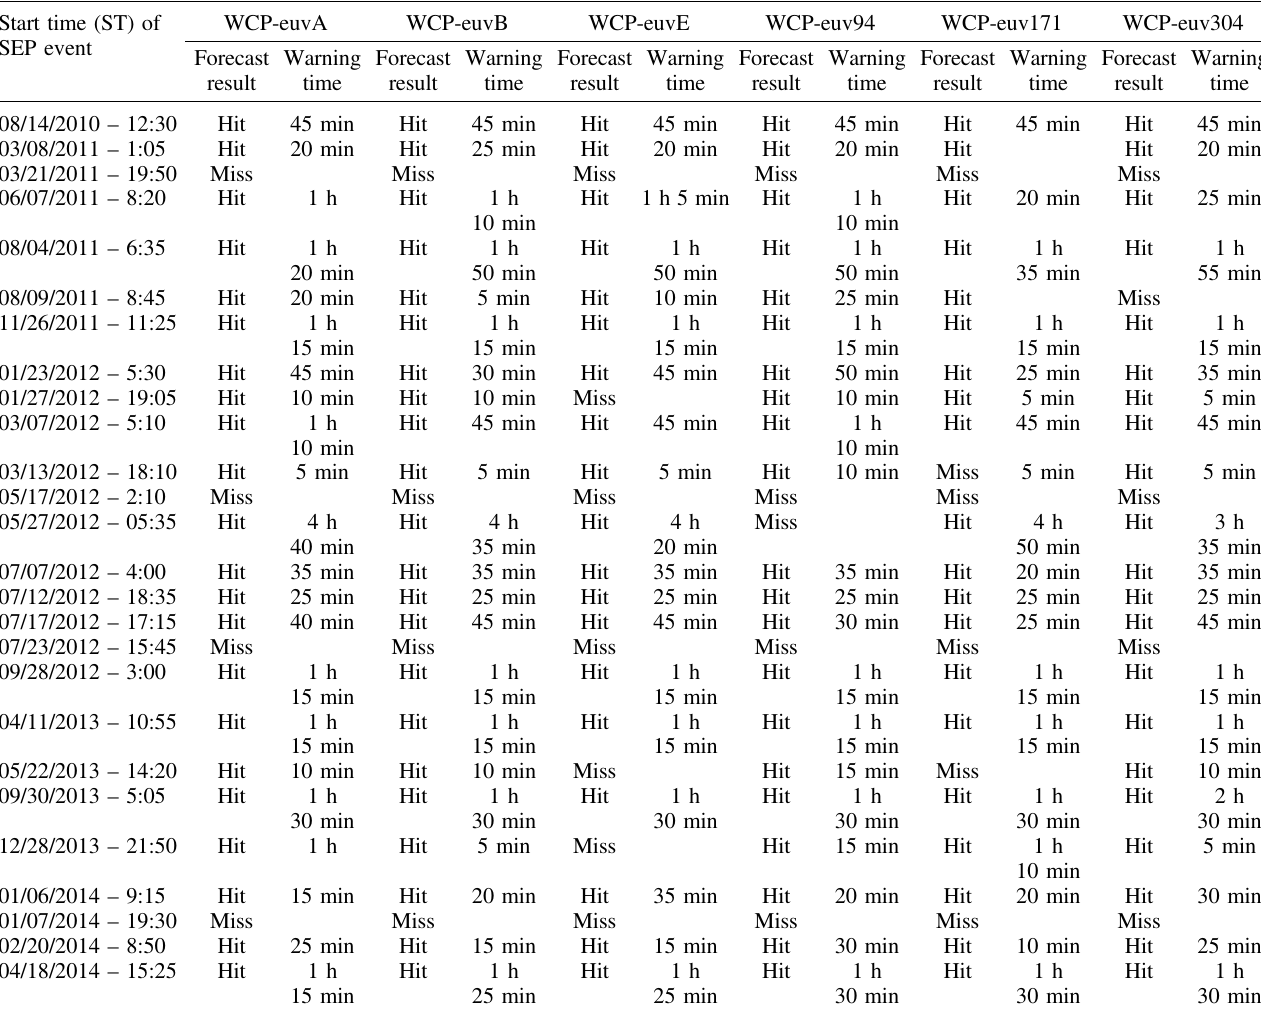
Table 4. Forecasting results of the WCP-euvA, WCP-euvB, WCP-euvE, WCP-euv94, WCP-euv171 and WCP-euv304 models using calibration GOES and SDO data for predicting all events in Table 1 that occurred from May 2010 to October 2014. Start time (ST) of SEP event